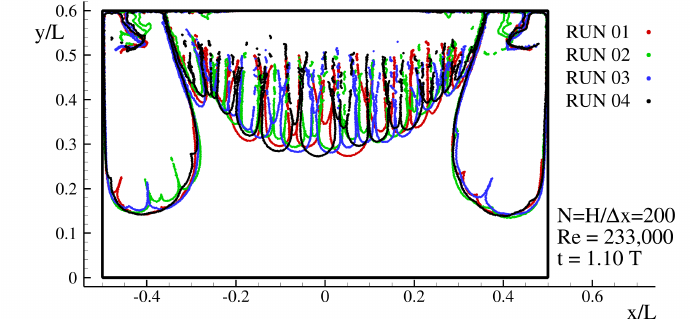
Figure 4. Test with water: free-surface particles for the first four simulations at the first roof